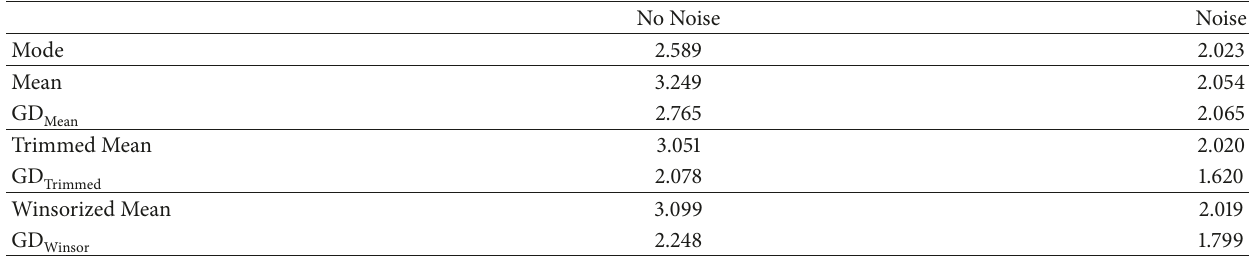
Table 80: Log-normal distributions with step noise (Type 4). The uniform noise is applied in the range from the minus maximum value to the minimum value of the distribution. The frequency of the samples increases linearly, going to create a noise-shaped step. The noise is composed of 1000